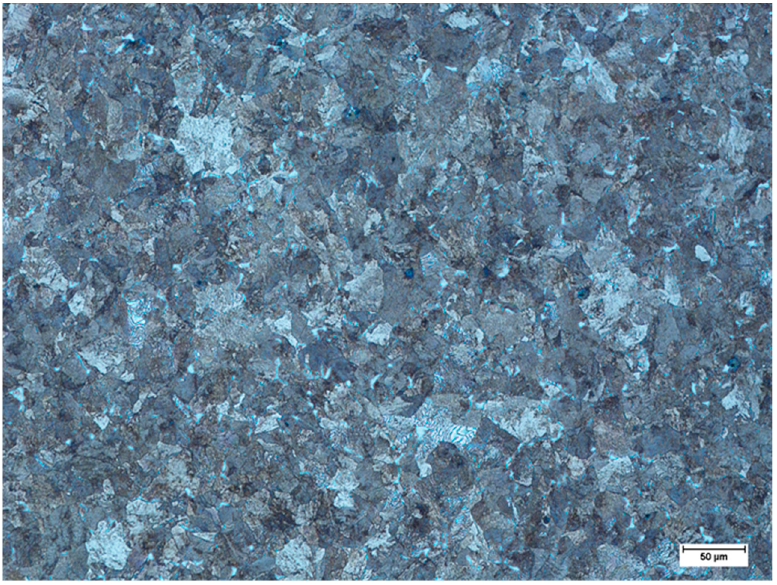
Figure 8. Typical microstructure of the steel matrix for the studied heats.